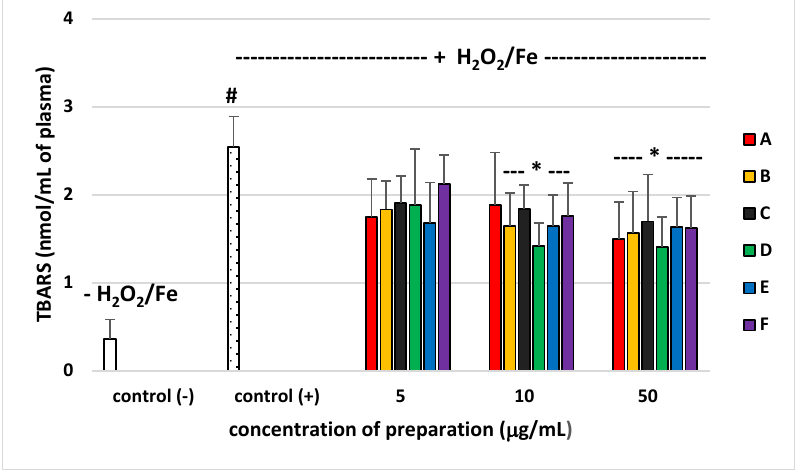
Figure 4. Effects of the preparations (A–F) of E. rhamnoides (L.) A. Nelson leaves and twigs (5–50 µg/mL; 30 min) on plasma lipid peroxidation induced by H 2 O 2 /Fe. Data represent means ± SD of six independent experiments. * p < 0.05 (vs. control (+)), # p < 0.01 (vs. control ( − )). Control negative (-) refers to plasma not treated with H 2 O 2 /Fe, whereas control positive (+) refers to plasma treated with H 2 O 2 /Fe.